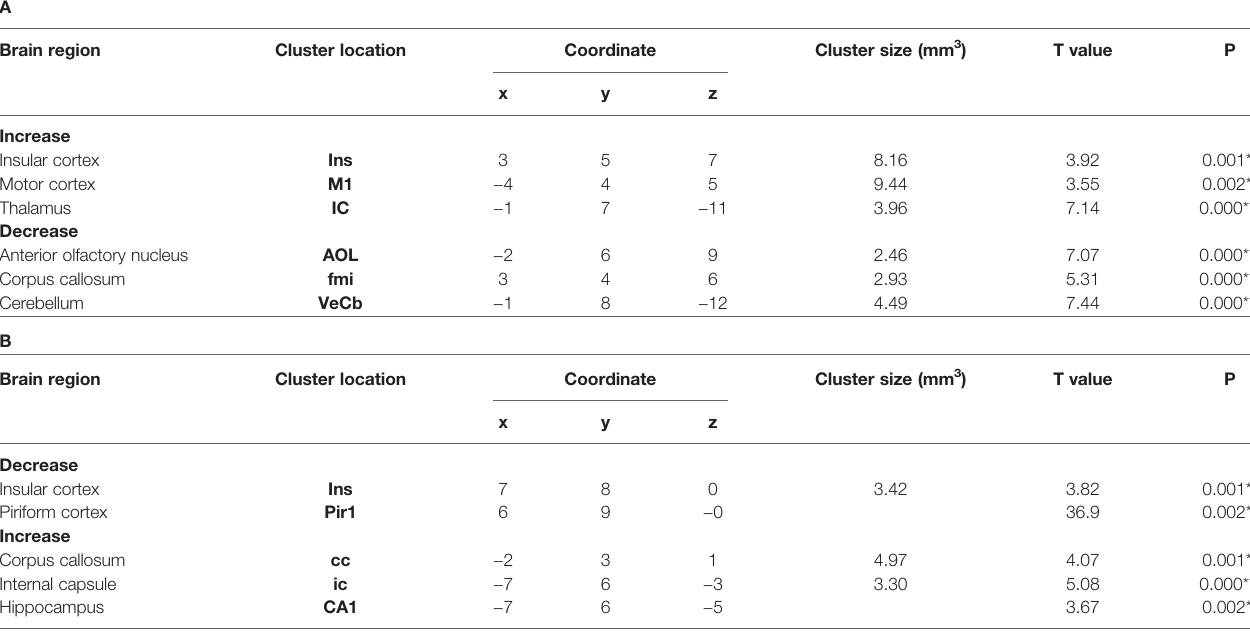
TABLE 3 | Brain regions changes in tree shrews with the treatment of ketamine and WMT by compared with baseline phase. A Brain